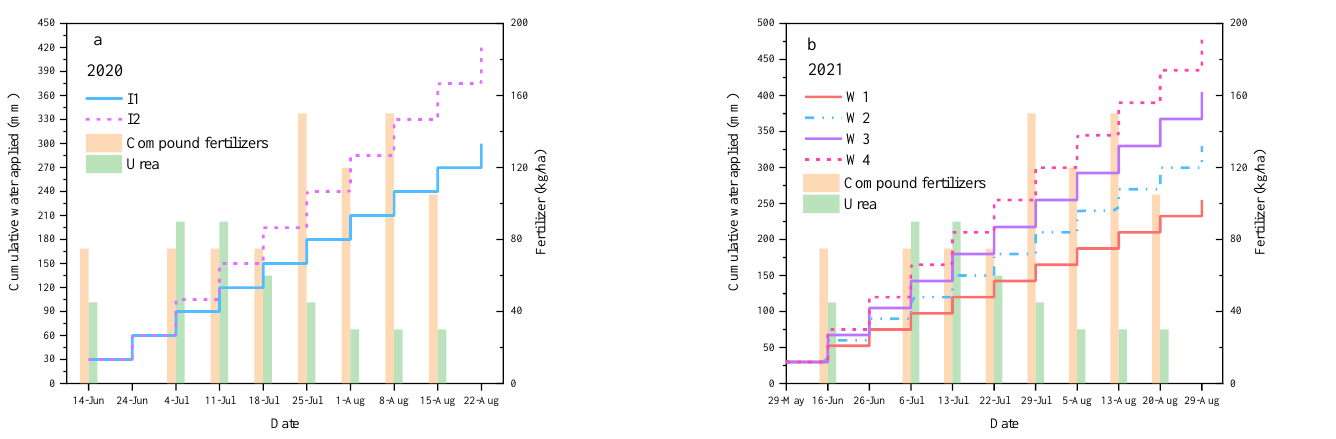
Figure 1. Planting pattern of drip-irrigated cotton with film mulching and depth of soil sampling.